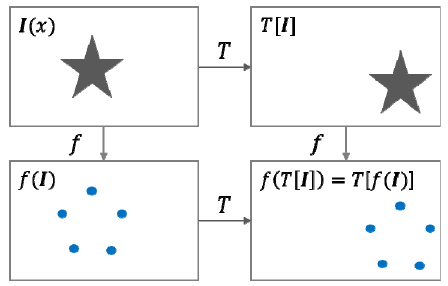
Figure 1. Illustration of a translational equivariance.